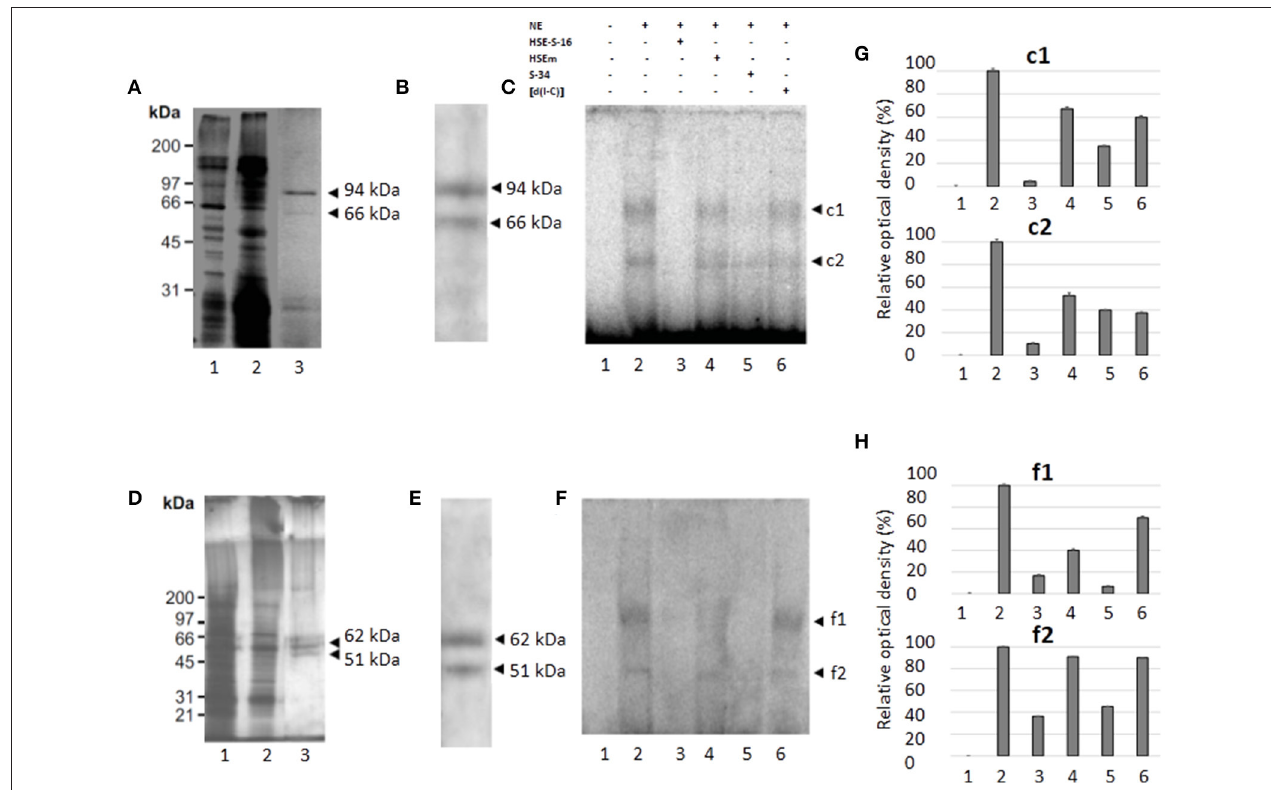
FIGURE 6 | Purification, immunodetection, and DNA-interaction of the nuclear proteins that bind to the HSE element (A,D) . 10% SDS-PAGE of protein fractions obtained from the purification protocol of NE from clones A [8] and C2 [20] , respectively. Lane 1, NE (5 µ g); lane 2, non-retained fraction; and lane 3, partially purified fraction. (B,E) Western blot analysis of fractions obtained from the purification protocol of NE of clones A [8] and C2 [20] , respectively. Arrowheads, silver stained polypeptides detected by antibodies against HSF1 from humans. (C,F) EMSA using [ γ - 32 P]-ATP radiolabeled HSE probe and partially purified fraction from clones A [8] and C2 [20] , respectively. Lane 1, free probe; lane 2, no competitor; lane 3, specific competitor unlabeled straight (150-fold molar excess); lane 4, specific competitor with the HSE mutated; lane 5, specific competitor containing the CdxA, YY1, and HSE consensus sequences; lane 6, unspecific competitor